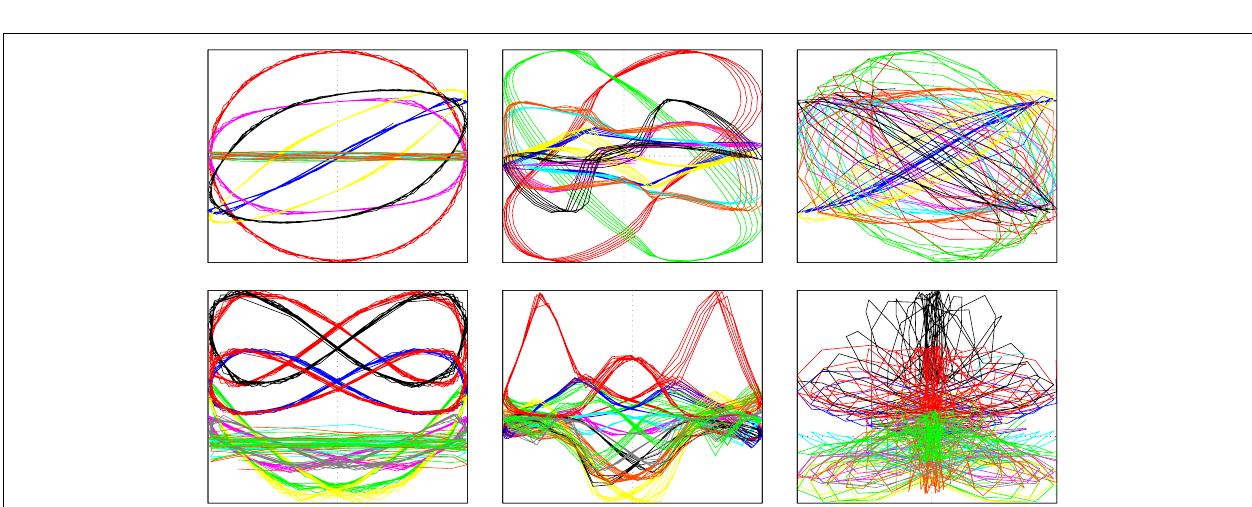
FIGURE 2 | Parametric plots of the sensor and learning dynamics with robot on level ground . Top row: sensor values x i ( t ) against x 0 ( t ) when in a stable rolling mode (left), when in one of the fast modes (middle), and in the chaotic behavior when switching between modes (right). Bottom row: several of the C ij ( t ) values against x 0 ( t ) in the corresponding situations. See videos S1 and S2 on the supplementary materials site (Der,